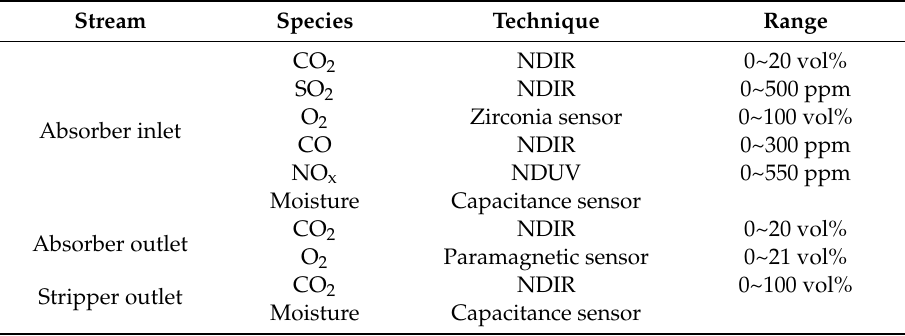
Table 5. Gas analyzers in the